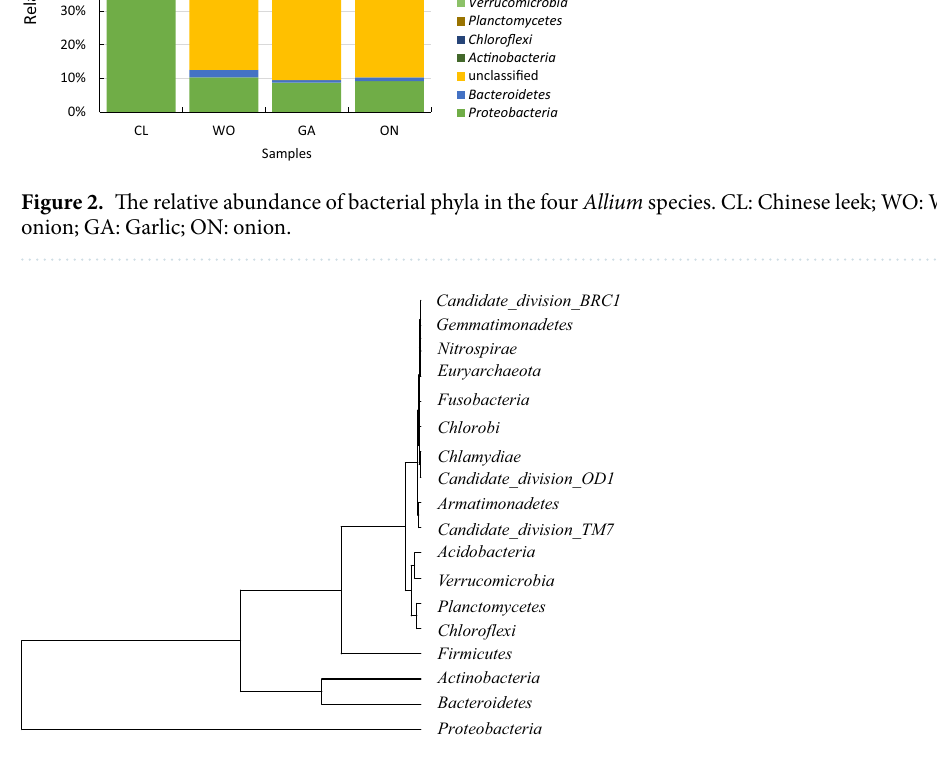
Figure 3. Hierarchical cluster tree of bacterial phyla in the four Allium